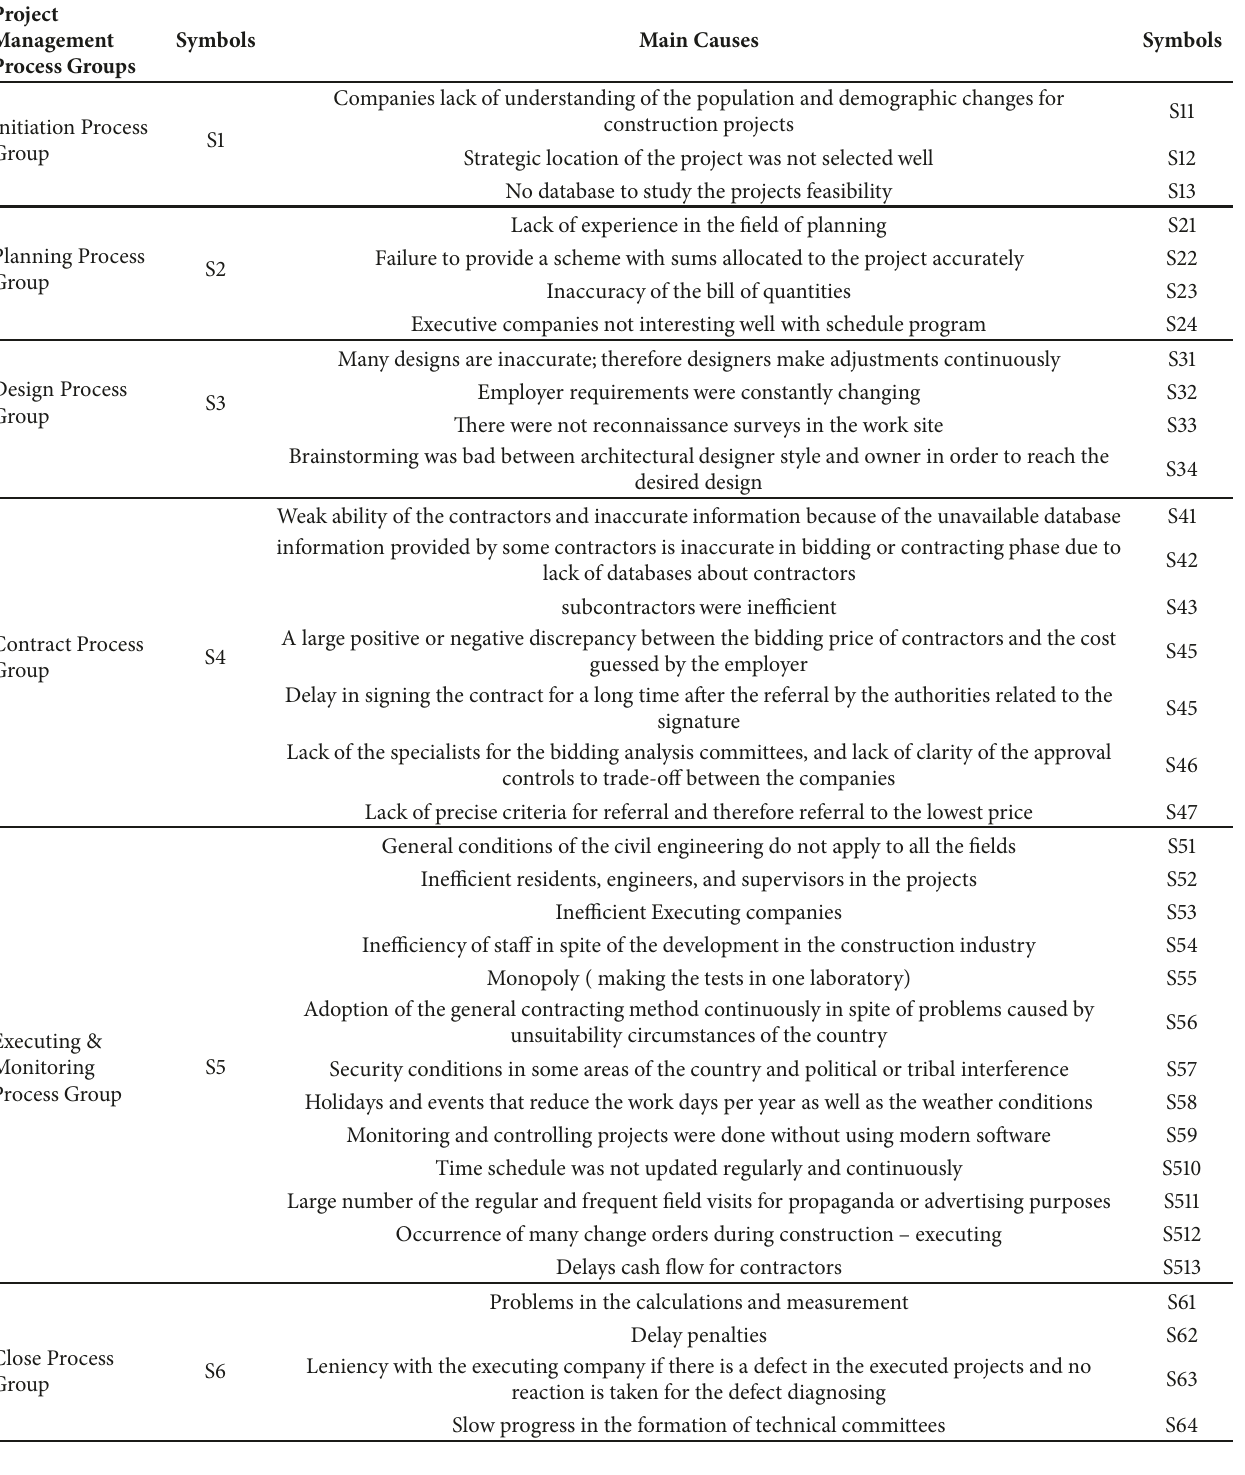
Table 1: Main causes of the failure of construction project in project management process